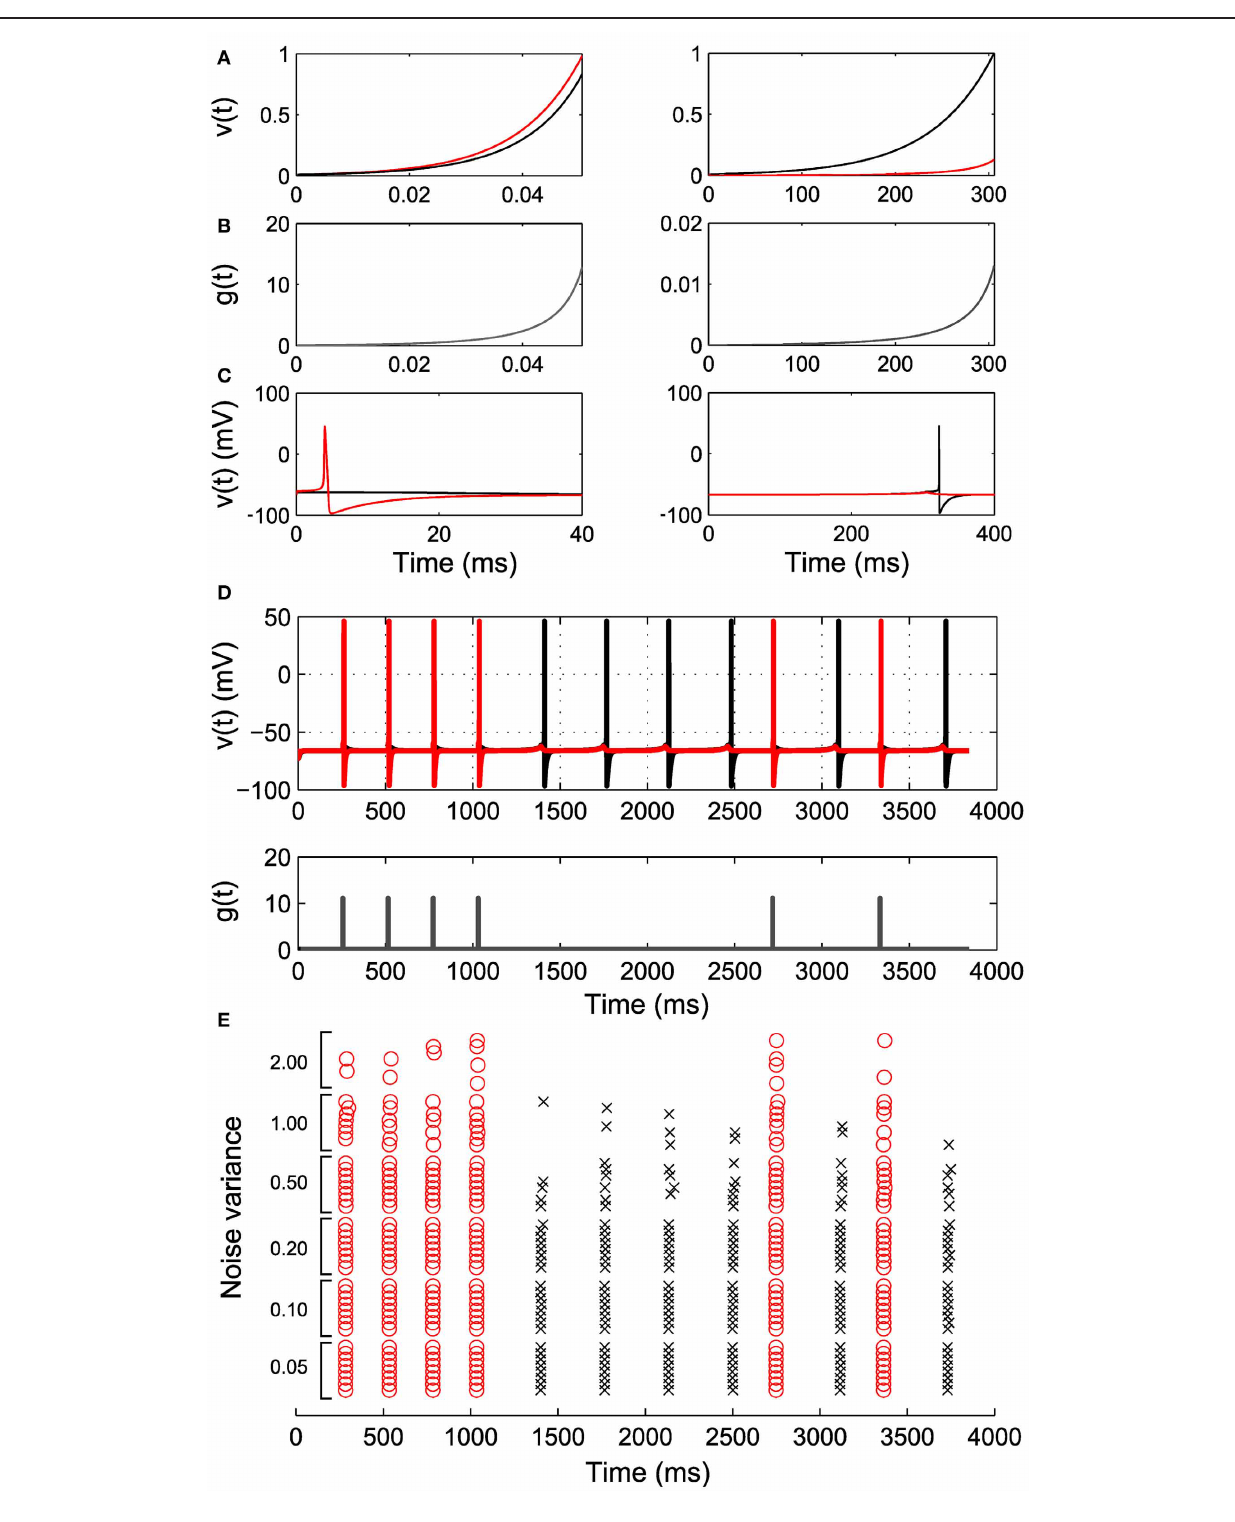
neurons to the derived control inputs, illustrating differential spiking. (D) An example spike sequence ( 111122221212 ) achieved by interleaving the derived inputs. Note the difference in magnitude and duration of g ( t ) in (B) . (E) Effect of noise of increasing variance on the achieved sequence. Eight realizations at each noise level are